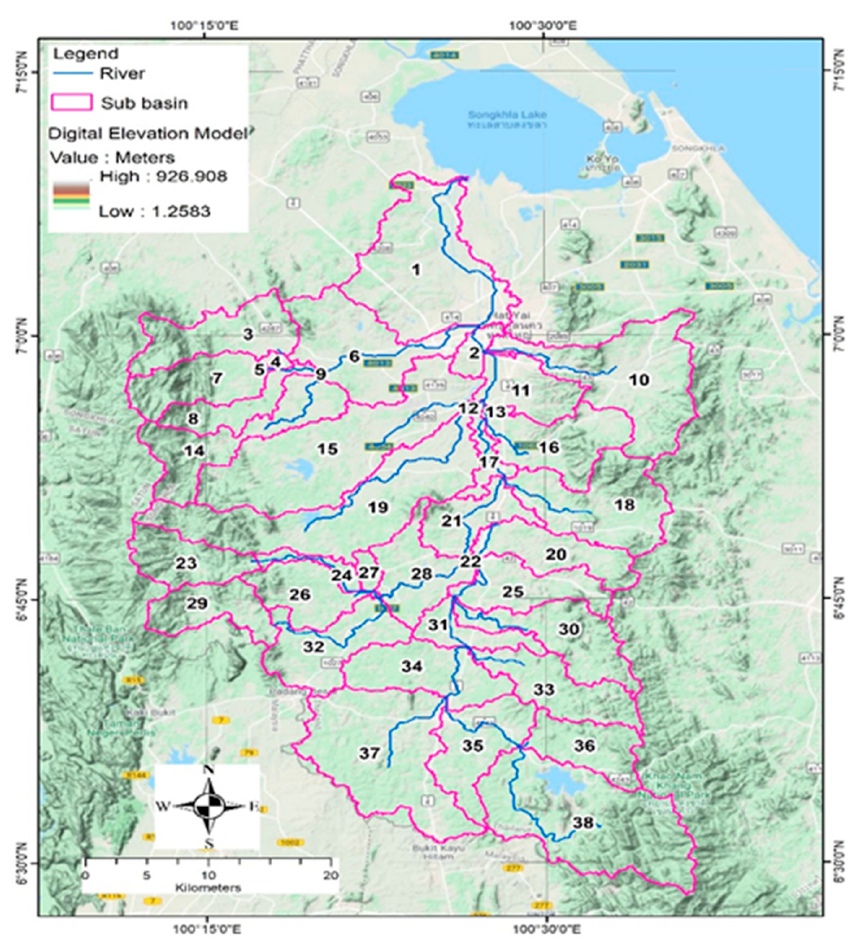
Figure 6. Sub-basins and stream network of the U-Tapao river basin (use color) .